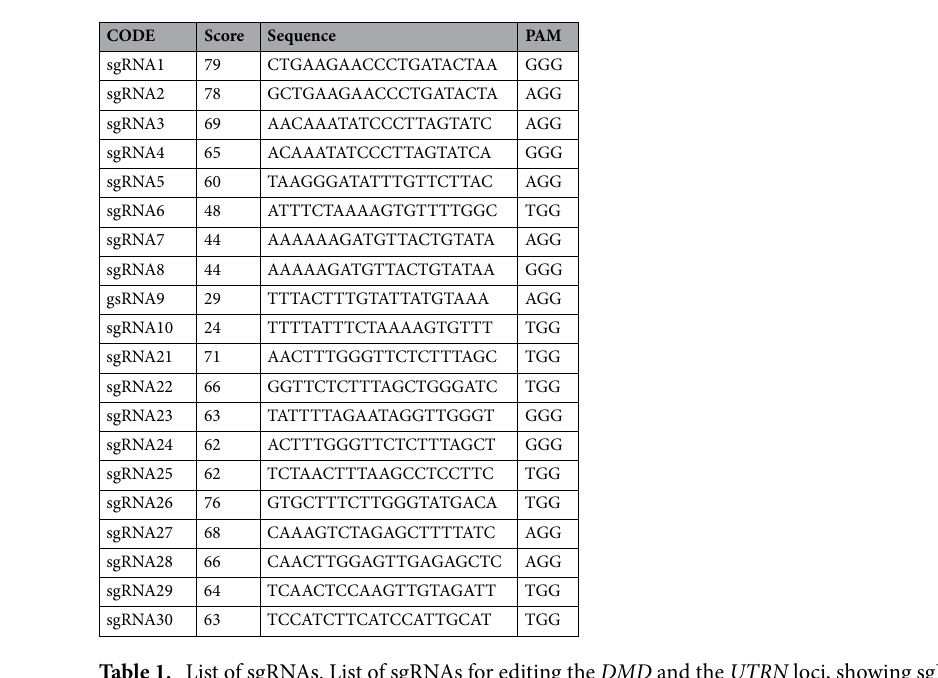
Table 1. List of sgRNAs. List of sgRNAs for editing the DMD and the UTRN loci, showing sgRNAs sequences, PAM sequences and scores of all sgRNA